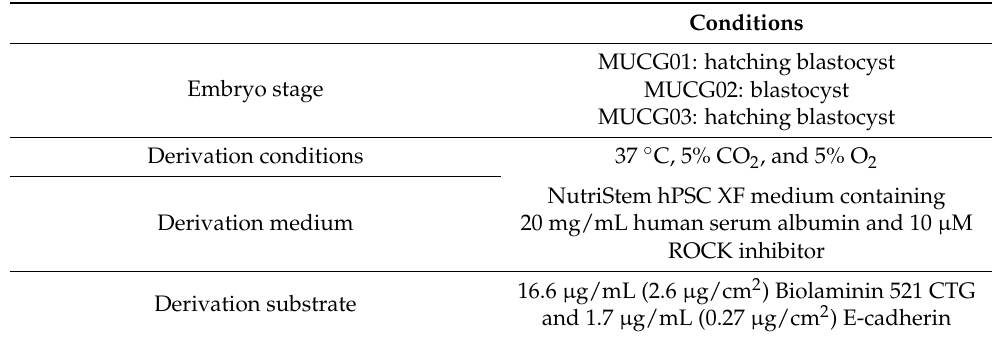
Table 2. Overview of the embryo stage and derivation conditions for the hESC lines MUCG01, MUCG02, and MUCG03.